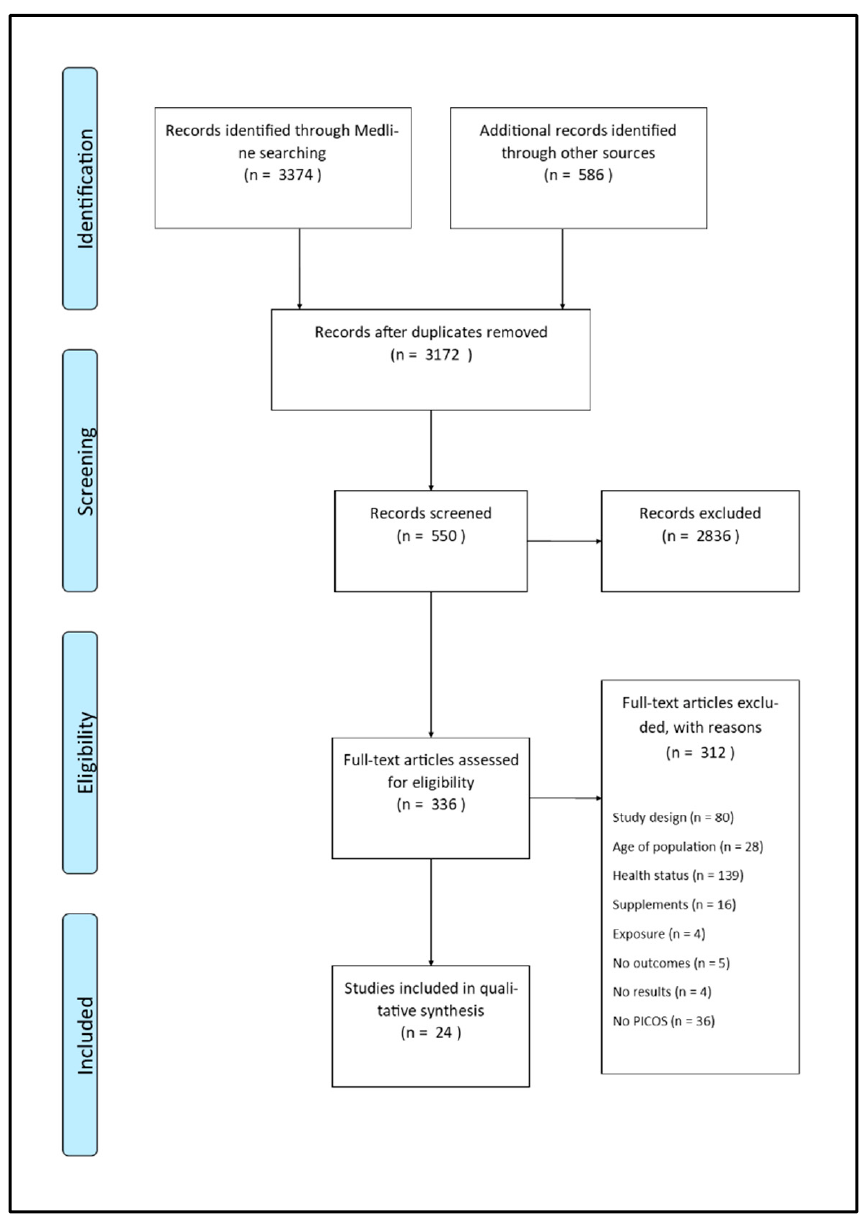
Figure 1. PRISMA flow diagram. The flow chart below represents the selection process of studies included in this systematic review, from the identification of records to the inclusion phase.